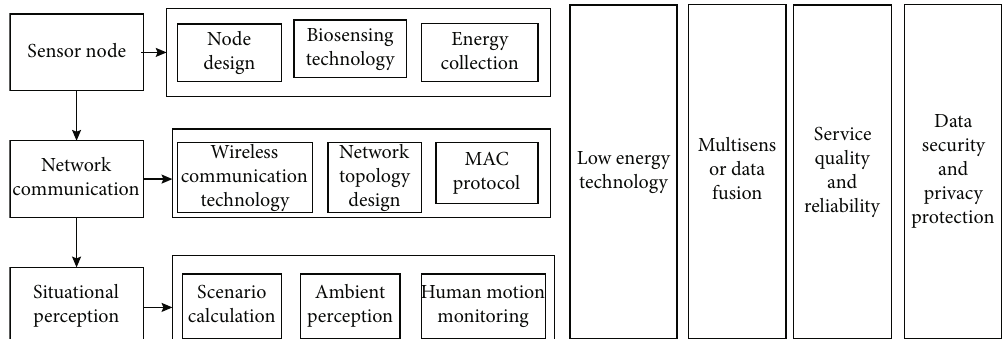
Figure 1: Research area of wireless body area